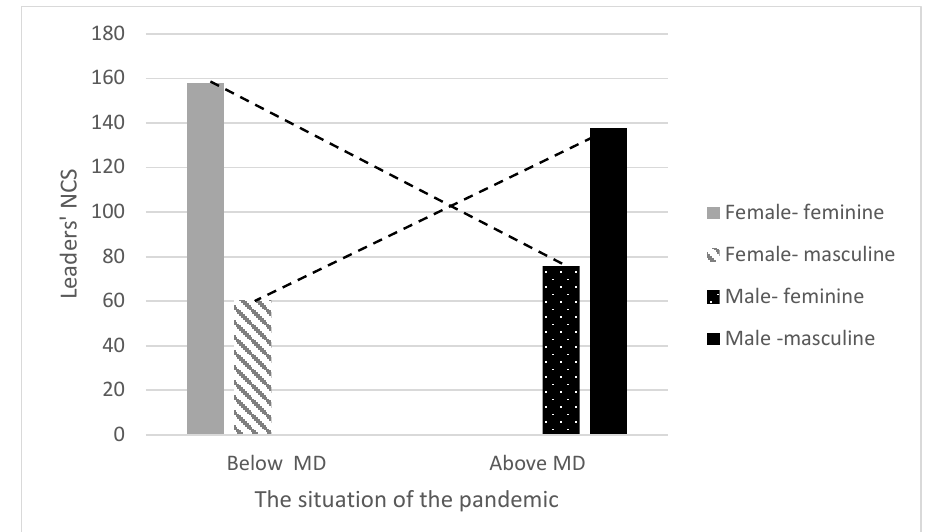
Figure 2. The interaction effect of gender and the situation of the pandemic on leaders’ NCS. (Note. We calculated a median score of the dead/sick ratio to represent the pandemic situation (0.1821) to create a cut-off score, such that below-median scores represent a better pandemic situation, while above-median scores represent a worse pandemic situation.).